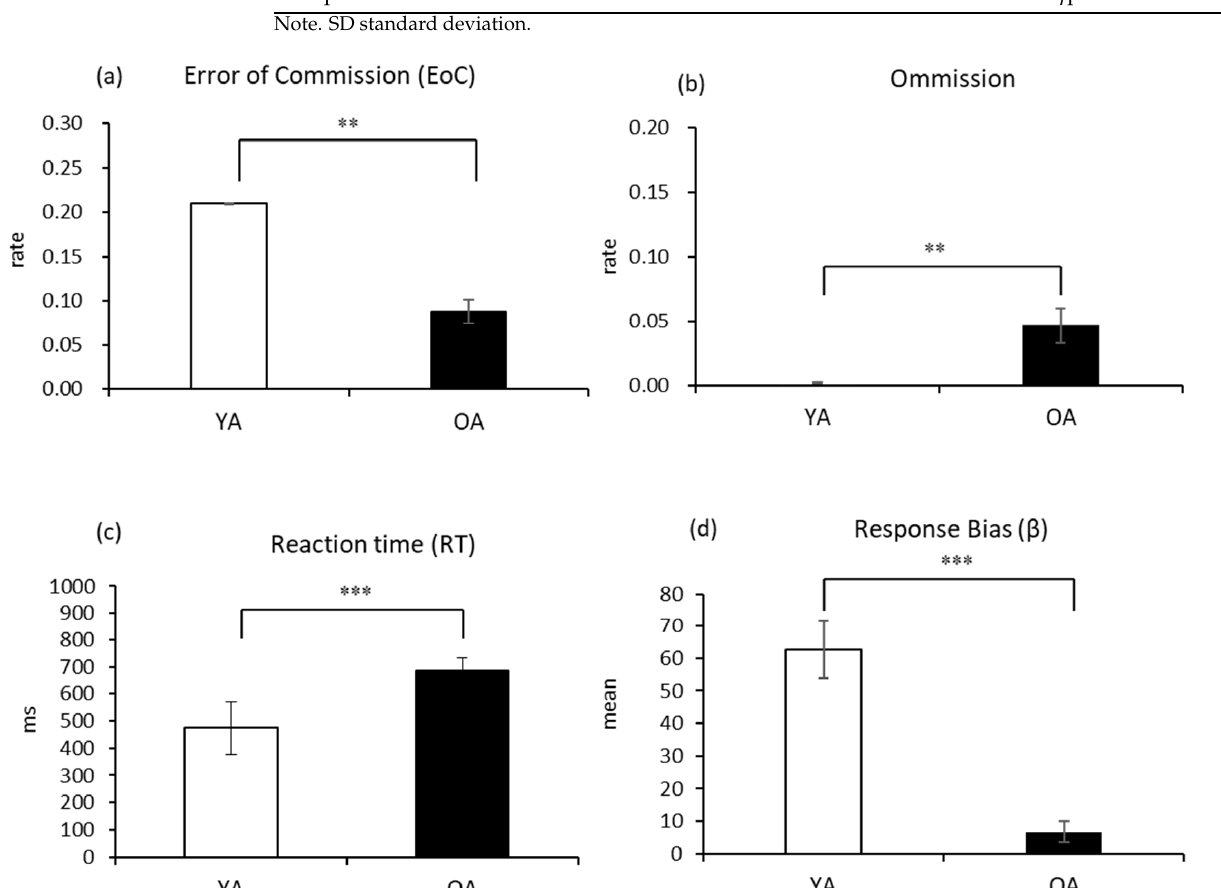
Table 3. The age effect on self-reported attentional control.